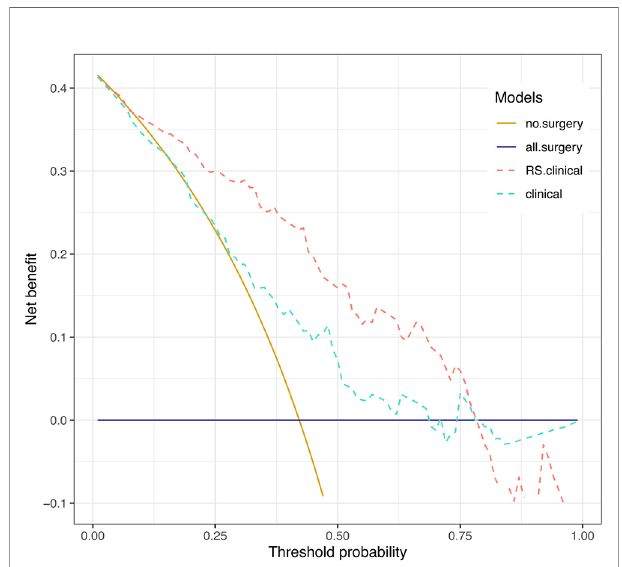
FIGURE 4 | Decision curve analysis. Decision curves depicting the net bene fi t (y-axis) of the two models at a range of probability thresholds (i.e., minimum probability of pCR above which a patient would opt for observation rather than surgery; x-axis). The yellow and blue solid lines represent making the same decision in all patients (i.e., Sparing surgery for all patients or performing surgery for all patients, respectively). The net bene fi t was corrected by internal validation of 2,000-replicate bootstrap.